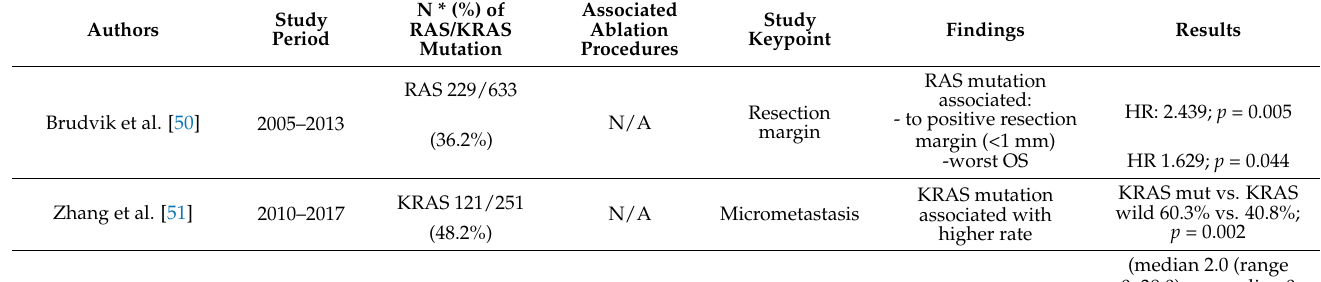
Table 2. Results of studies reporting implications of RAS mutations on surgical resection of colorectal liver metastases.